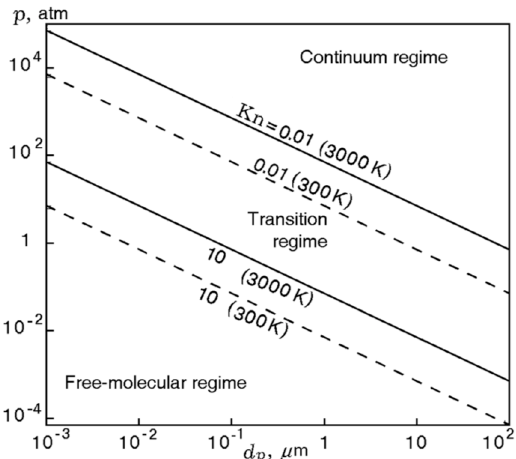
Figure 5. Boundaries between the continuum and free-molecular regimes as a function of particle size at different pressures and temperatures 300 and 3000 K. Reproduced from [14], with permission from Elsevier, 2015.